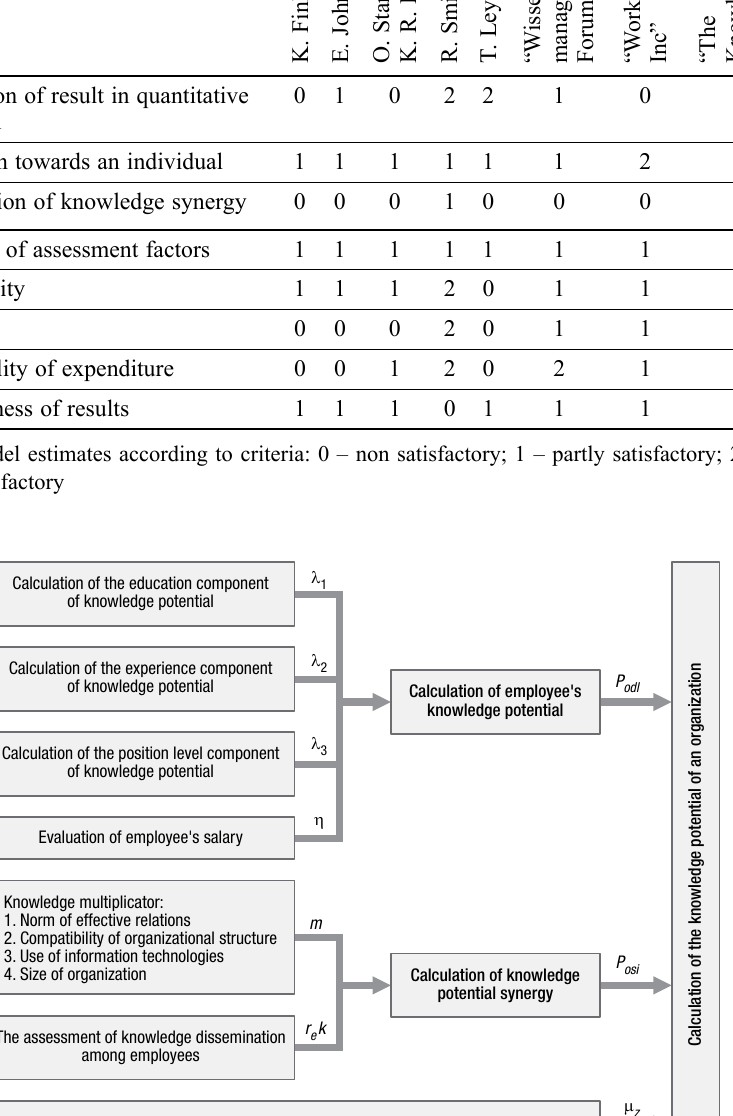
Criteria of comparison